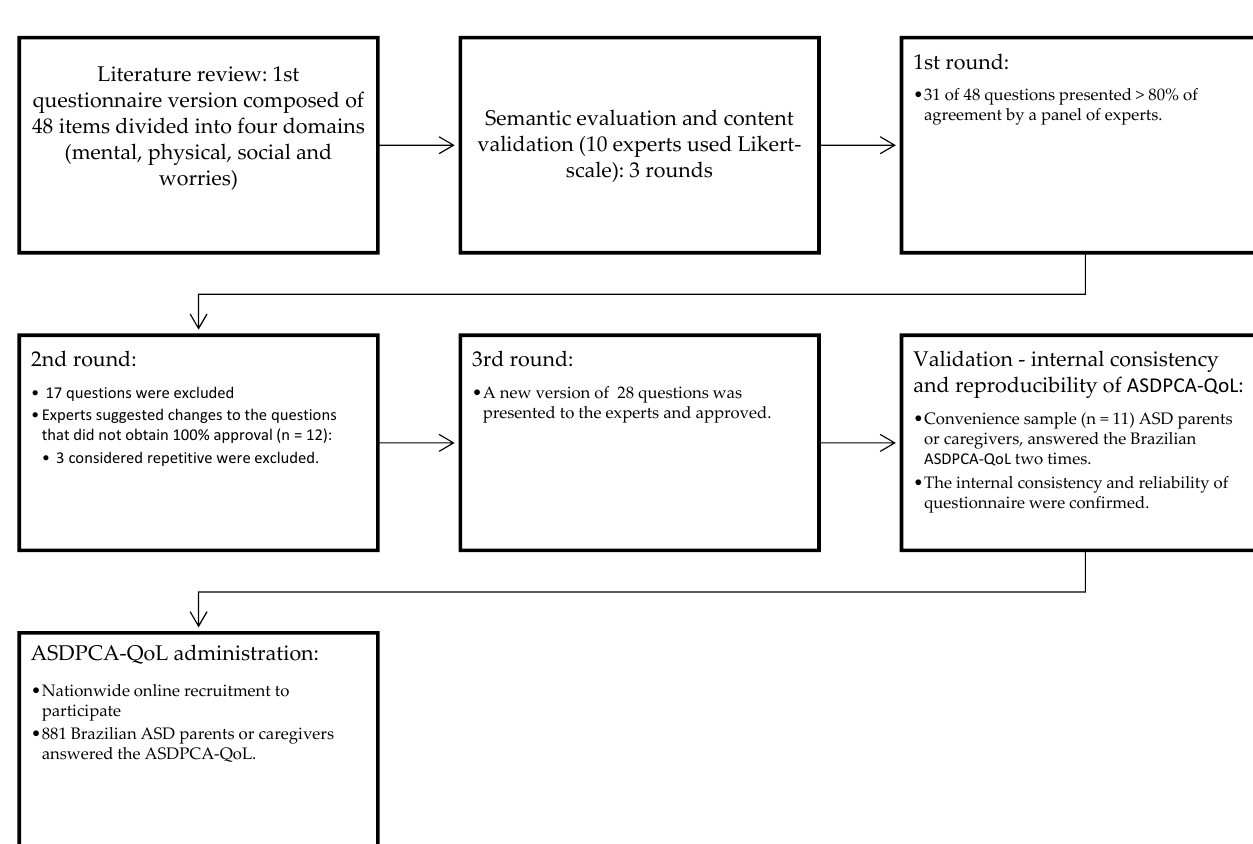
Figure 1. Flowchart of questionnaire development, semantic evaluation, content validation processes, and administration of the ASDPCA-QoL.